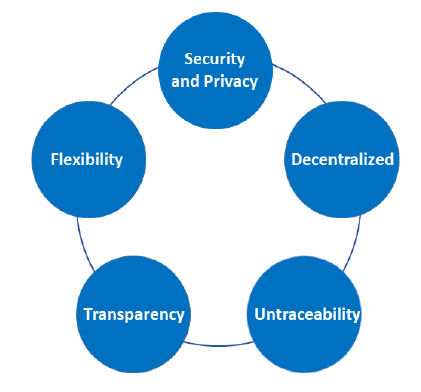
Figure 2: Features of Blockchain